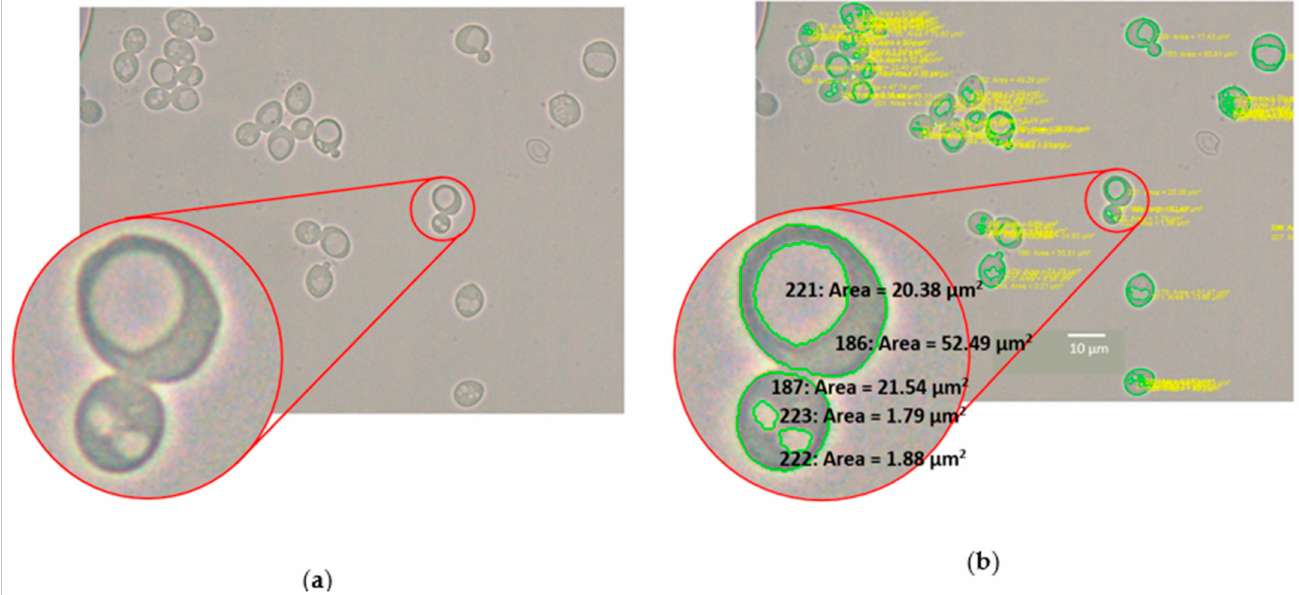
Figure 1. ( a ) Microscope image of yeast during fermentation (1000 × ) with enlarged budding cell (counted as two individual yeast cells) to show shading difference between vacuole and yeast cell in a raw image; ( b ) The same image after manual analysis of cell and vacuole cross-sectional area